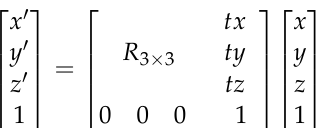
Figure 2. Fixture used for rough positioning to make the measuring and theoretical coordinate system close. The process of fine matching requires translation and rotation operation of six degrees of freedom, to achieve accurate alignment between the surfaces of the measured and theoretical systems. In the spatial coordinate system, the rotation and translation coordinate transformation corresponds to the rigid body transform. According to the transfer matrix, the point P ( x , y , z ) in the measured surface changed to point P (cid:48) ( x (cid:48) , y (cid:48) , z (cid:48) ) in the theoretical coordinate system, as shown in the Equation (1).